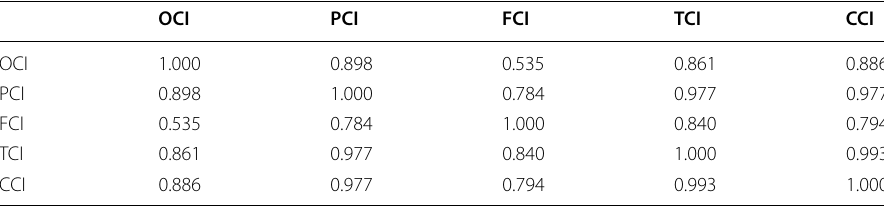
From January 1, 2012, to August 31, 2020, with weekly